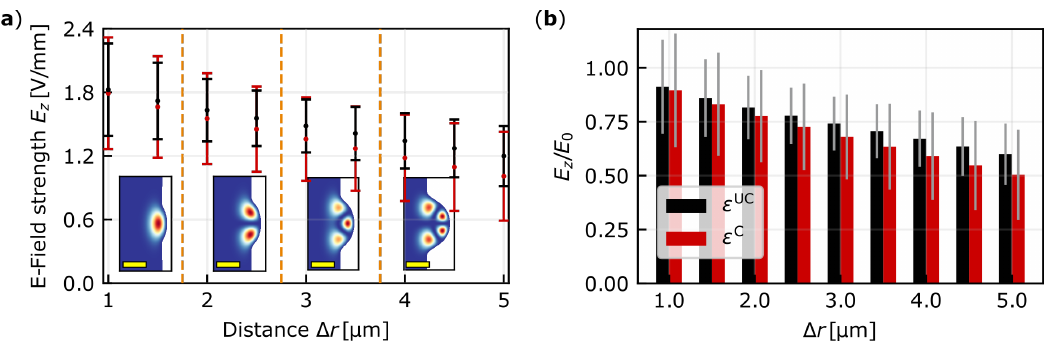
Figure 7. ( a ) The average electric field strength E z in the few-mode resonator with small radius r s = 5µm in the area where the normalized intensity of the fundamental optical mode is larger than 10%. The red data points represent the strength E z with (cid:101) C and black the one with (cid:101) UC . The error bars represent ∆ E z . The inset show the highest possible optical mode. The yellow bar has a size of 5µm. ( b ) Comparison between the electric field E z and the respective field in a plate capacitor E 0 . The gray bars as a measure for the field inhomogeneity are given by ∆ E z / E 0